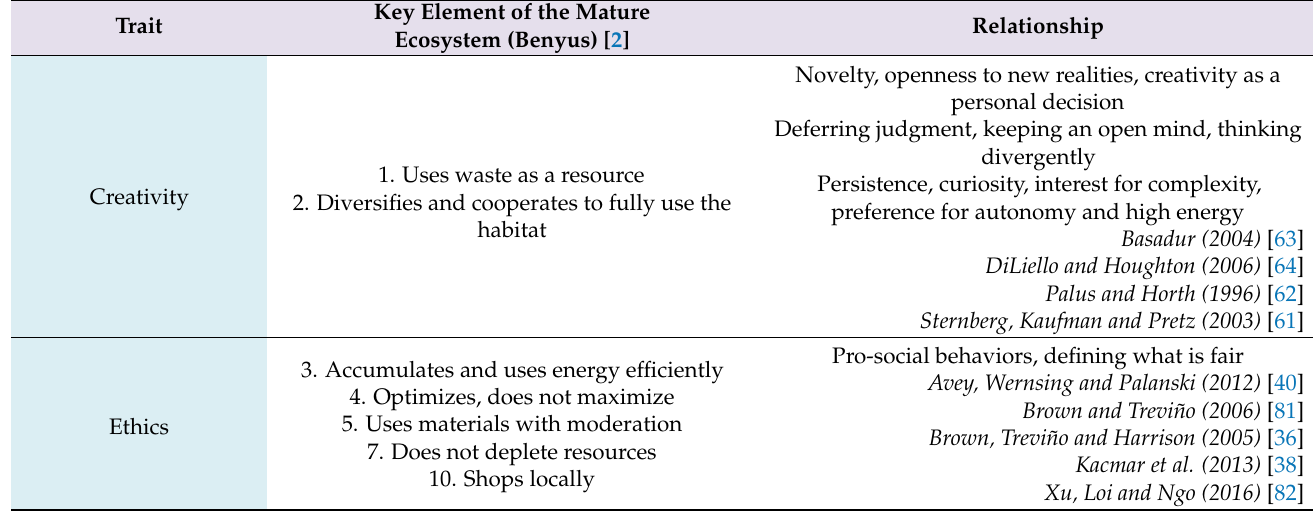
Table 2. Comparison between the traits of the biomimetic leader and the 10 key elements of a mature system.